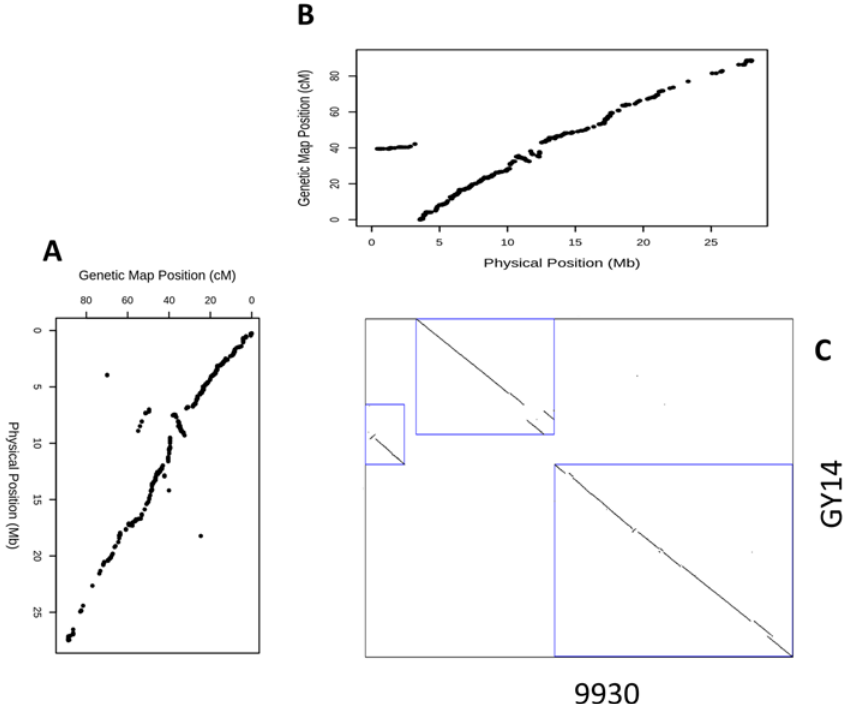
Fig 3. Genetic and physical map comparison for chromosome 5. Scatter plots of marker positions on the genetic map against the positions of the genome reference of both (A) ‘ 9930 ’ and (B) ‘ Gy14 ’ . These maps were drawn to their relative axis in a dot plot (C) of the two genomes for